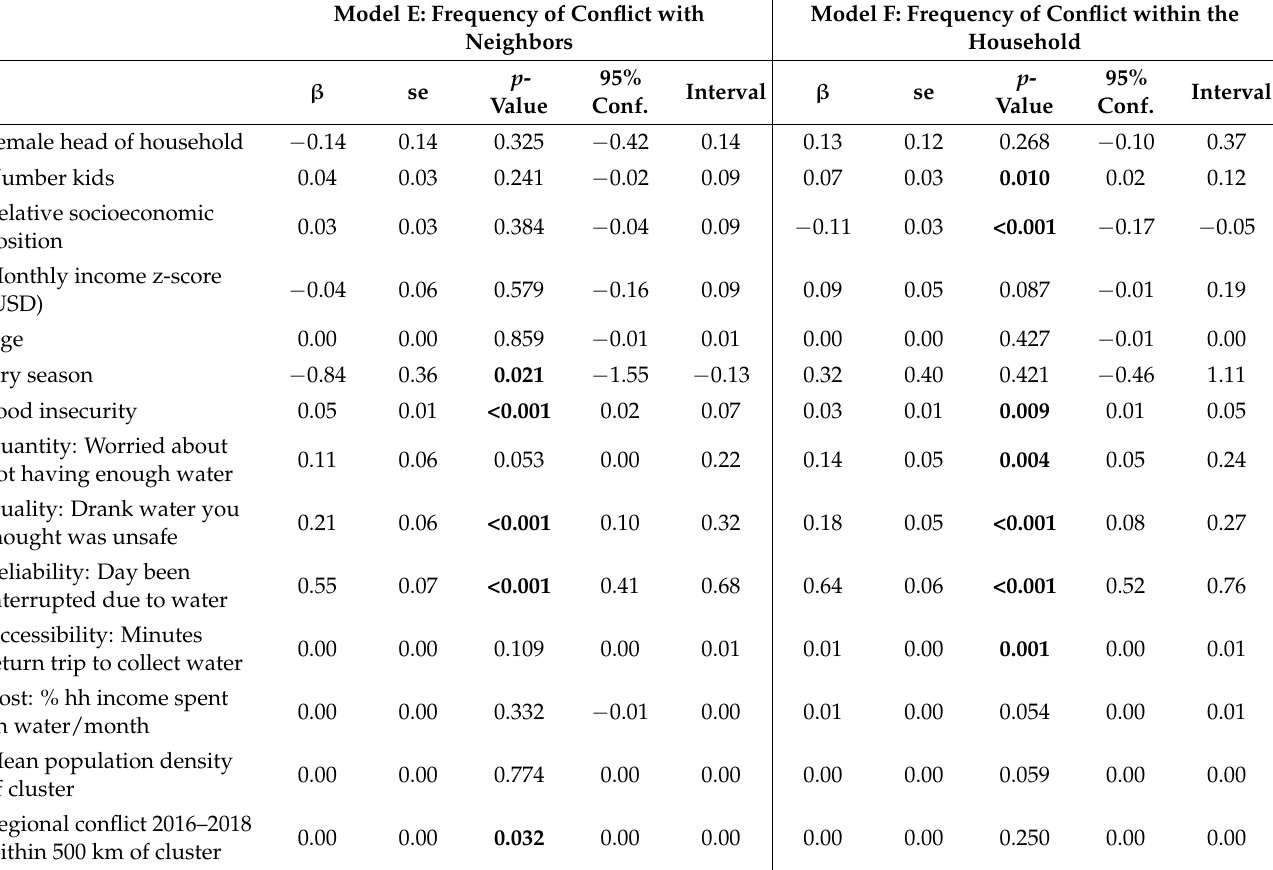
Table 6. Ordinal logistic regression modeling results for associations between demographic characteristics, water insecurity domains, regional conflict, population density, and conflict with neighbors (Model E) or within the household (Model